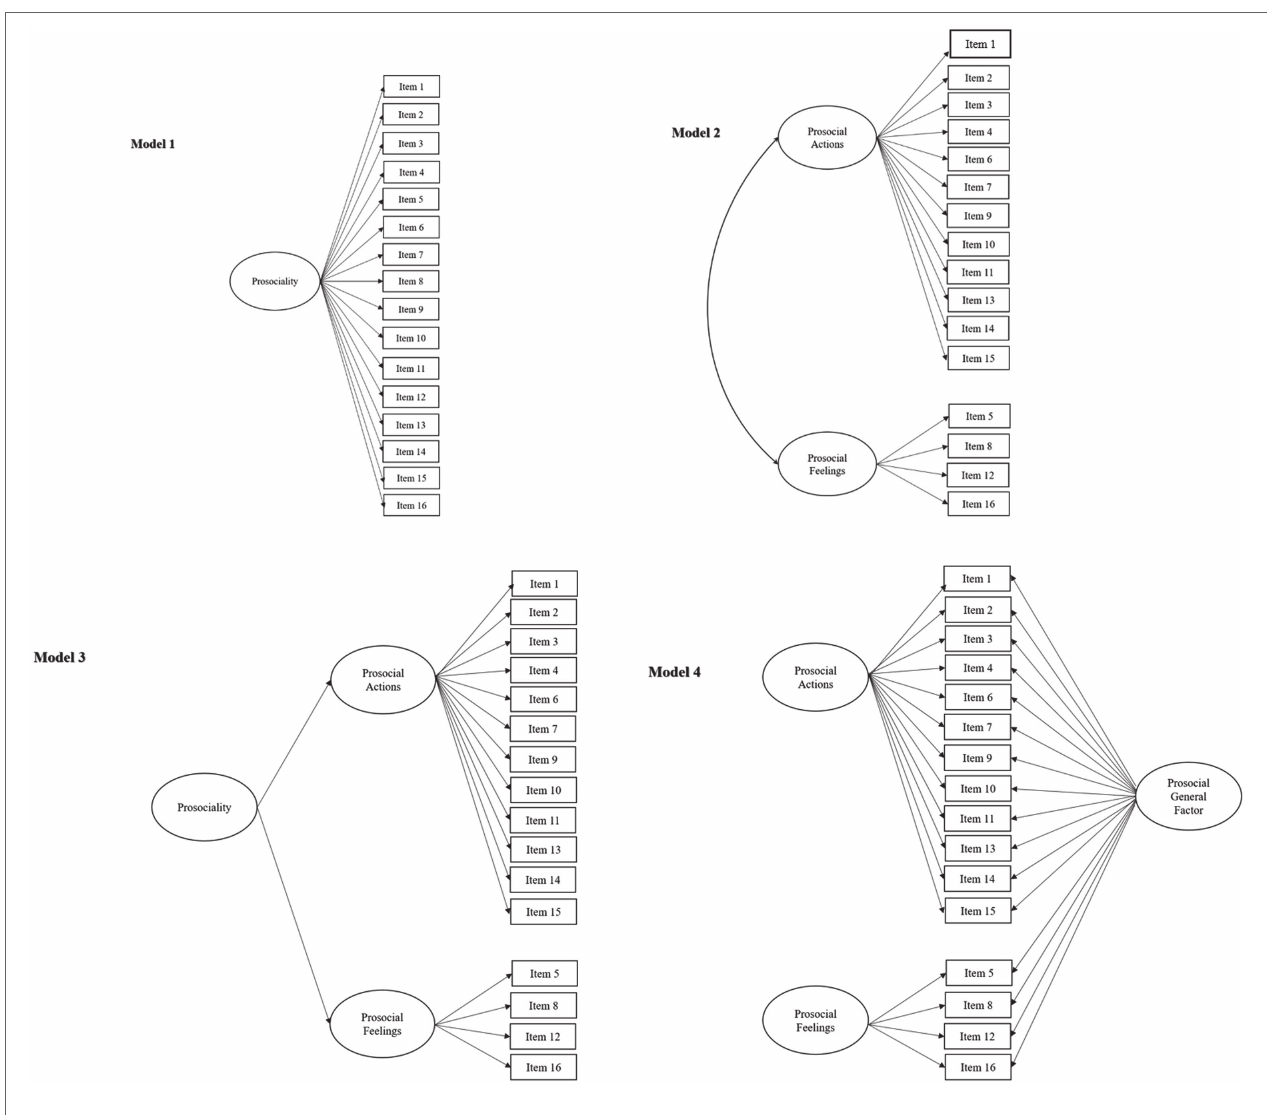
FIGURE 1 | Plausible factorial models for the Prosociality